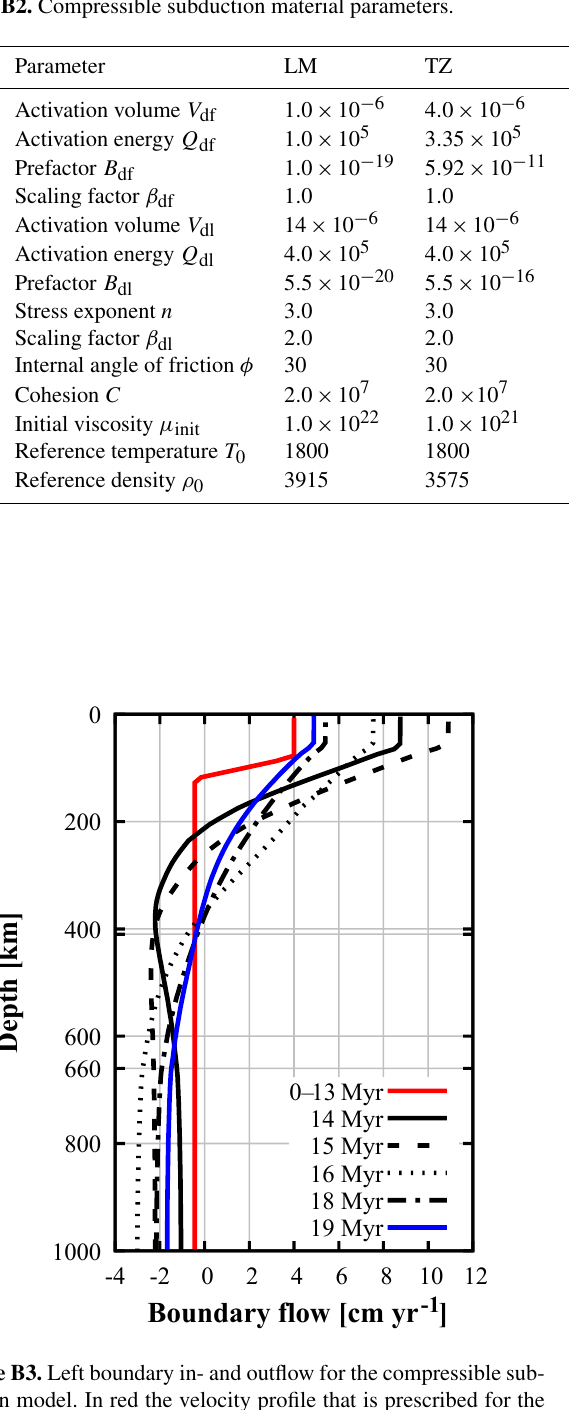
Table B2. Compressible subduction material parameters.